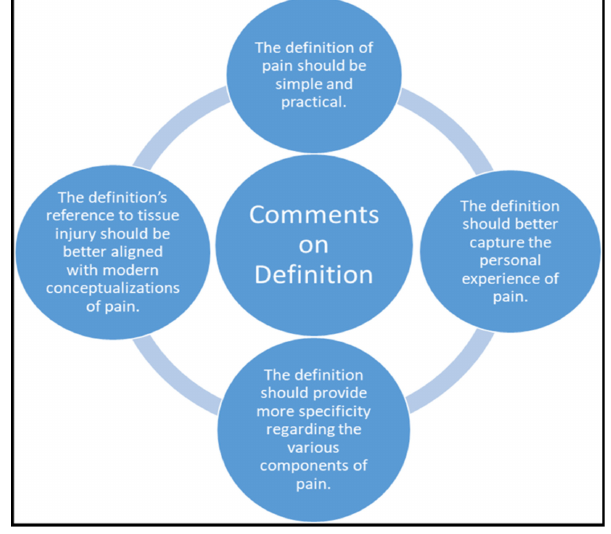
Figure 2. Comments on the Definition of Pain (IASP, 2018).